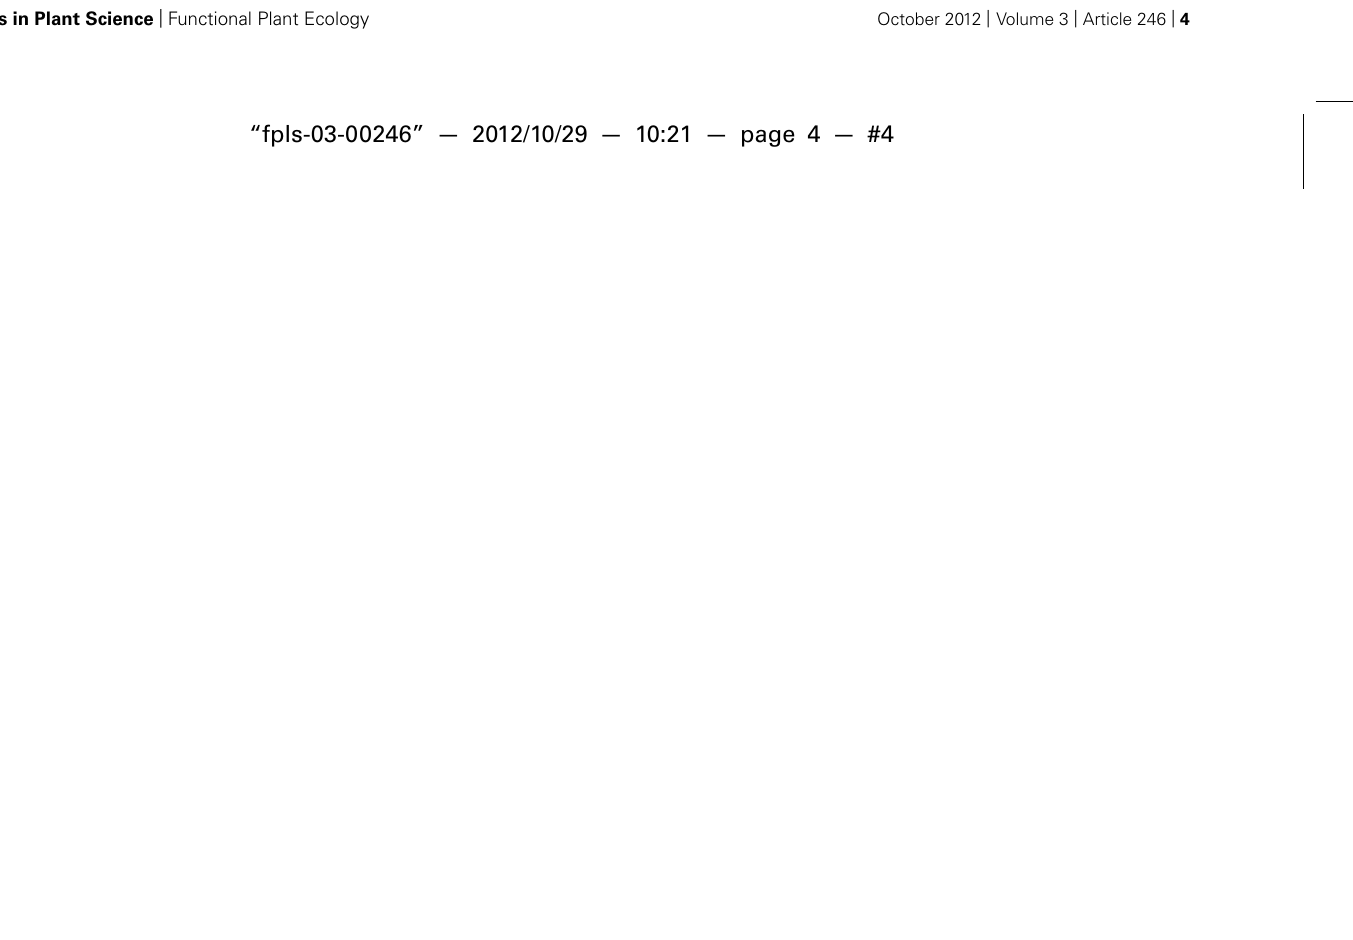
level at which growth or resource balance becomes neutral (see Figure 3 ). Automated measurements of growth are increasingly being adopted, but these are generally restricted to comparing different genotypes. (D) The ultimate goal of screening experiments is to relate interspecific differences in tolerance values obtained for drought, shade and low nutrients to differences among species in performance, abundance, or distributions, such as the distribution of the C 4 grass Aristida purpurea in the US displayed over mean annual precipitation. In this stage, data may have to be reduced in dimensionality or phylogenetically weighted.Trait values are then substituted for species identity and the explanatory power of different traits